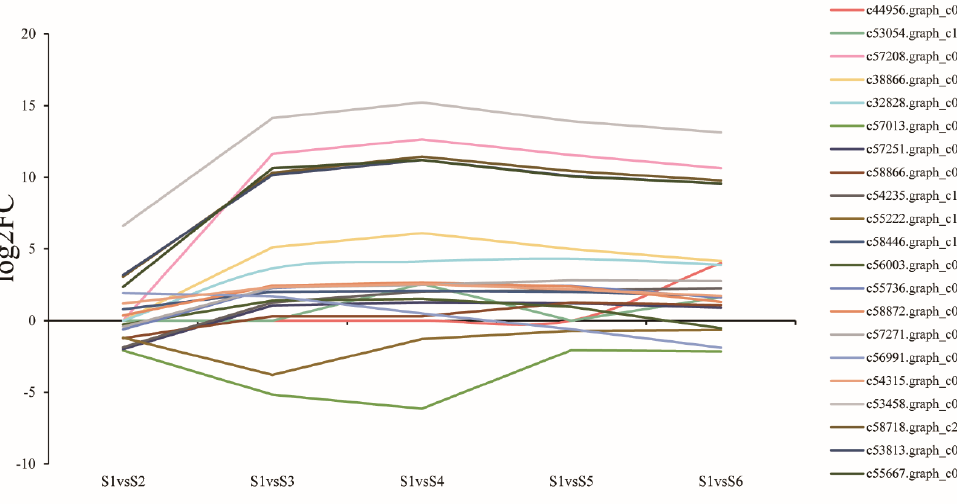
Figure 9. The log 2 of the fold change variations of sucrose synthase-related genes at five time points. The sugar metabolism, including pentose phosphate and glycolysis, is ubiquitous in most organisms and plays an important role in the development of xylem in plants [34]. As shown in Supplementary Table S3, there are a total of 66 DEGs in S1 vs. S2, 149 in S1 vs. S3, 149 in S1 vs. S4, 110 in S1 vs. S5 and 107 in S1 vs. S6 related to polysaccharide biosynthesis and metabolism. It can be seen that the number of DEGs is the highest in S3,